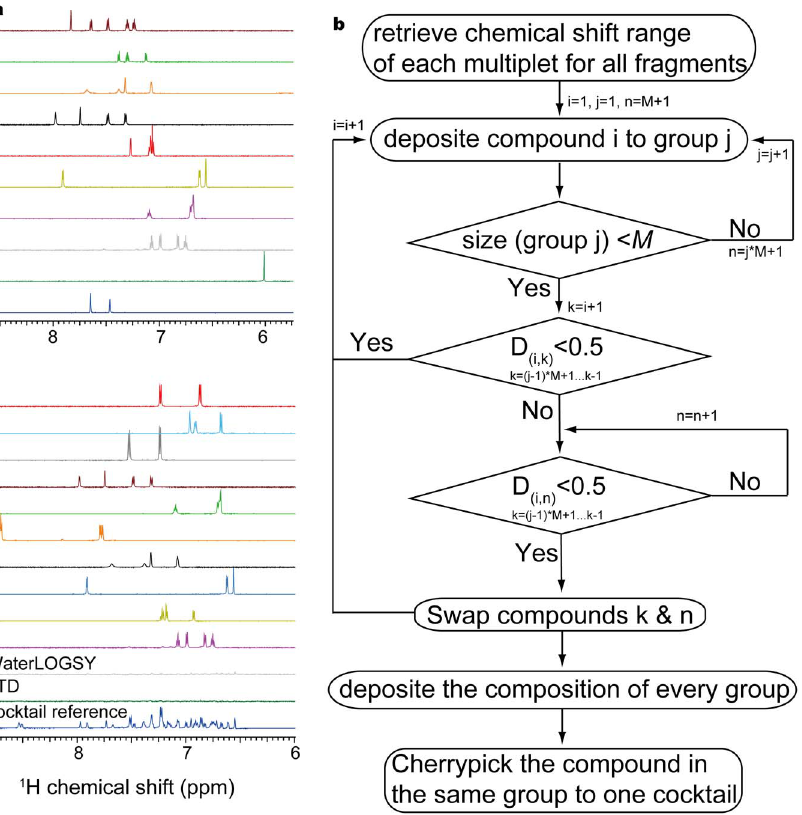
Figure 3. The preparation of dispersed fragment cocktails. a) The spectra of 10 fragments in an aliphatic order of the compound IDs. b) The scheme of grouping compounds with mutual dispersed spectra. c) The typical components of a cocktail (top ten spectra) prepared based on the grouping strategy. The cocktail 1D proton, STD and WaterLOGSY spectra (three bottom ones) were acquired for every cocktail in the absence of proteins as a negative control.